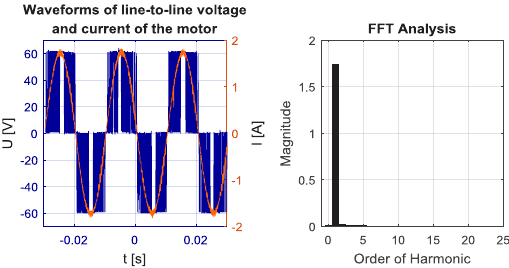
Fig. 2. The waveforms of the line-to-line voltage and phase current for the three-phase induction motor at frequency of 50 Hz and corresponding FFT current analysis.